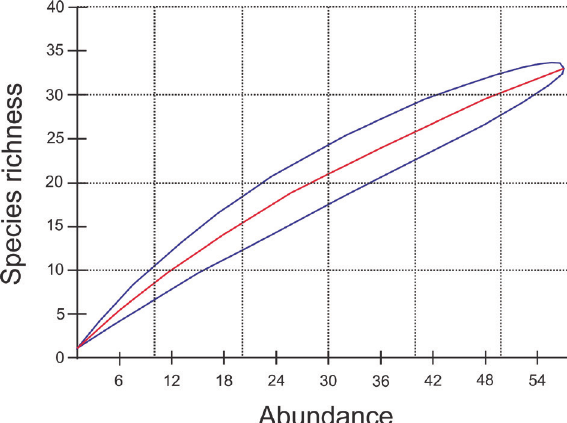
Figure 2. Thinning curves representing the accumulated richness of species of frogs and lizards at REBIO Gurupi. The richness was recorded by passive and active collection between December 2012 and May 2013. The center line is the average (randomizing 1000 times) and the lines on the side represent the associated standard